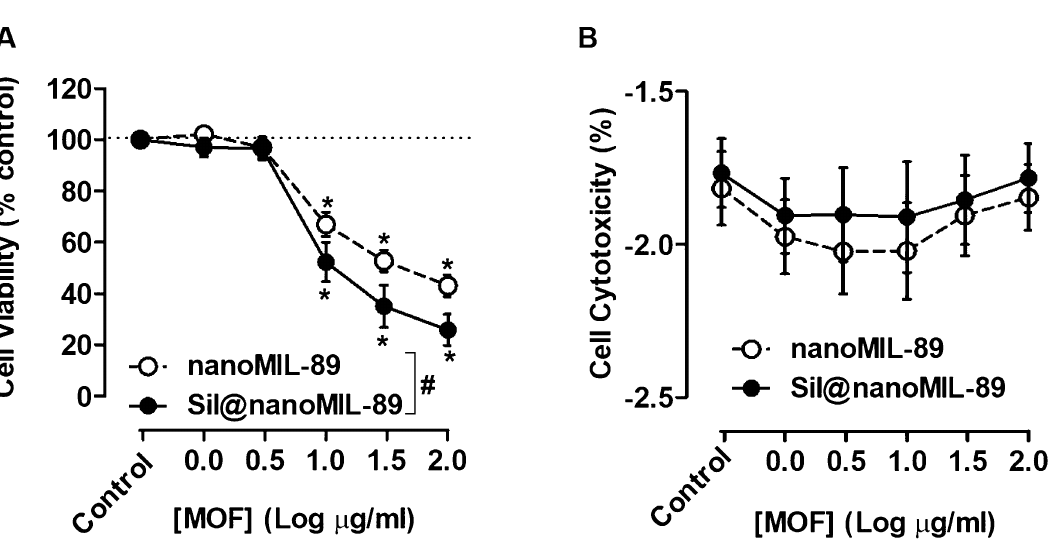
Figure 4. Effect of nanoMIL-89 and Sil@nanoMIL-89 on cell viability in human pulmonary artery smooth muscle cells (HPASMCs). Data are shown as mean ± SEM for n = 6 determinations using cells from 3 different donors. Effect on viability was calculated at % control for ( A ) and % cytotoxicity for ( B ). Statistical analysis for effects between nanoMIL-89 and Sil@nanoMIL-89 was determined by two-way ANOVA followed by Bonferroni Multiple Comparison test where statistical significance was assumed where ( # P < 0.05) and for each one compared to the relevant controls by one-way ANOVA followed by Dunnett’s Multiple Comparison Tests where statistical significance was assumed where (*P < 0.05). Analysis was performed on non-normalised data shown in Supplementary Fig.